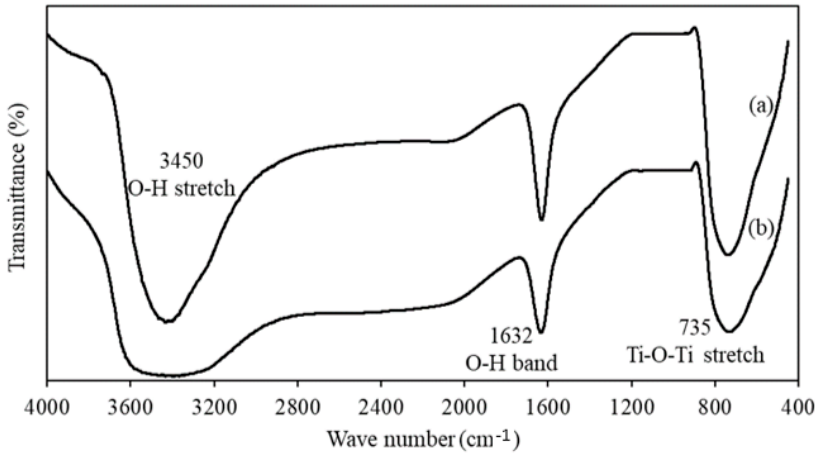
Figure 2. FTIR spectra of ( a ) TiO 2 -300; ( b ) 0.1Fe-TiO 2 -300.